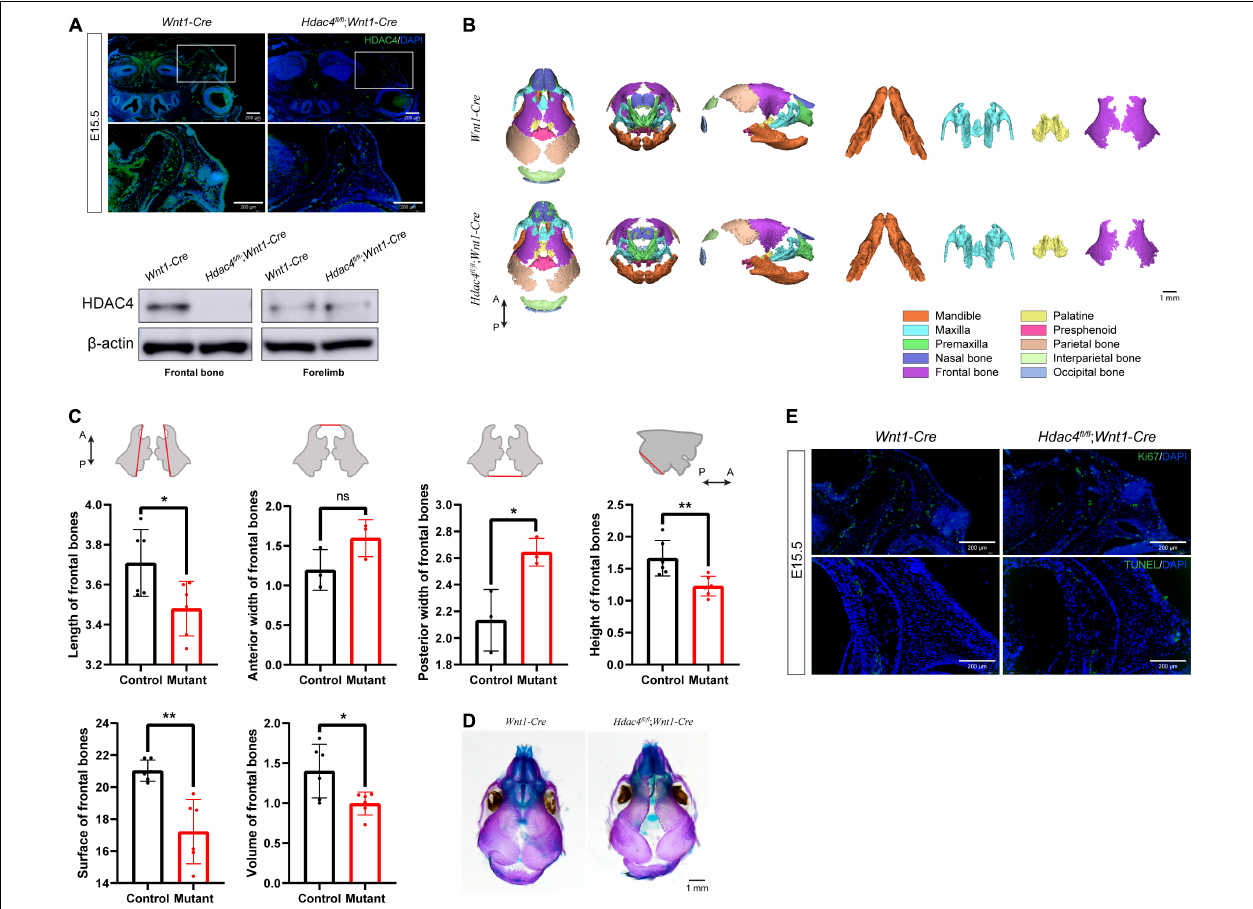
FIGURE 2 | The conditional knockout of Hdac4 in cranial neural crest cells (CNCCs) results in an underdeveloped frontal bone. (A) Immunofluorescence staining of HDAC4 in frontal bone at E15.5. Western blotting of frontal bone and forelimbs in control and Hdac4 fl / fl ;Wnt1-Cre mutant mice at P0. (B) Posteroanterior, lateral, and frontal views of micro-computed tomographic rendering of a skull of a P0 Wnt1-Cre and Hdac4 fl / fl ;Wnt1-Cre mutant mouse. Note the decreased frontal bone formation in the Hdac4 fl / fl ;Wnt1-Cre mutants. The maxilla, mandible, palatine bone, and frontal bone were isolated at P0. Hdac4 fl / fl ;Wnt1-Cre mutant mice exhibited smaller frontal bones and there was a wider interfrontal gap between frontal bones compared with that in Wnt1-Cre (control) mice. The palatine bones of Hdac4 fl / fl ;Wnt1-Cre mutant mice were slightly smaller than those of Wnt1-Cre mice, while the maxilla and mandibles were of normal size and had no macroscopic deformities. (C) Quantification of the size (length, width, and height) of frontal bones from control ( n = 3) and Hdac4 fl / fl ;Wnt1-Cre mutant mice ( n = 3). Comparison of the surface area and volume of frontal bones from control ( n = 3) and Hdac4 fl / fl ;Wnt1-Cre mutant mice ( n = 3). P → A: posterior to anterior. * P < 0.05; ** P < 0.01; ns. not significant. (D) Skeletal preparations showing the top view of the frontal bones in the P0 control and Hdac4 fl / fl ;Wnt1-Cre mutant pups. (E) Immunofluorescence staining of Ki67 and TUNEL staining in the frontal bone at